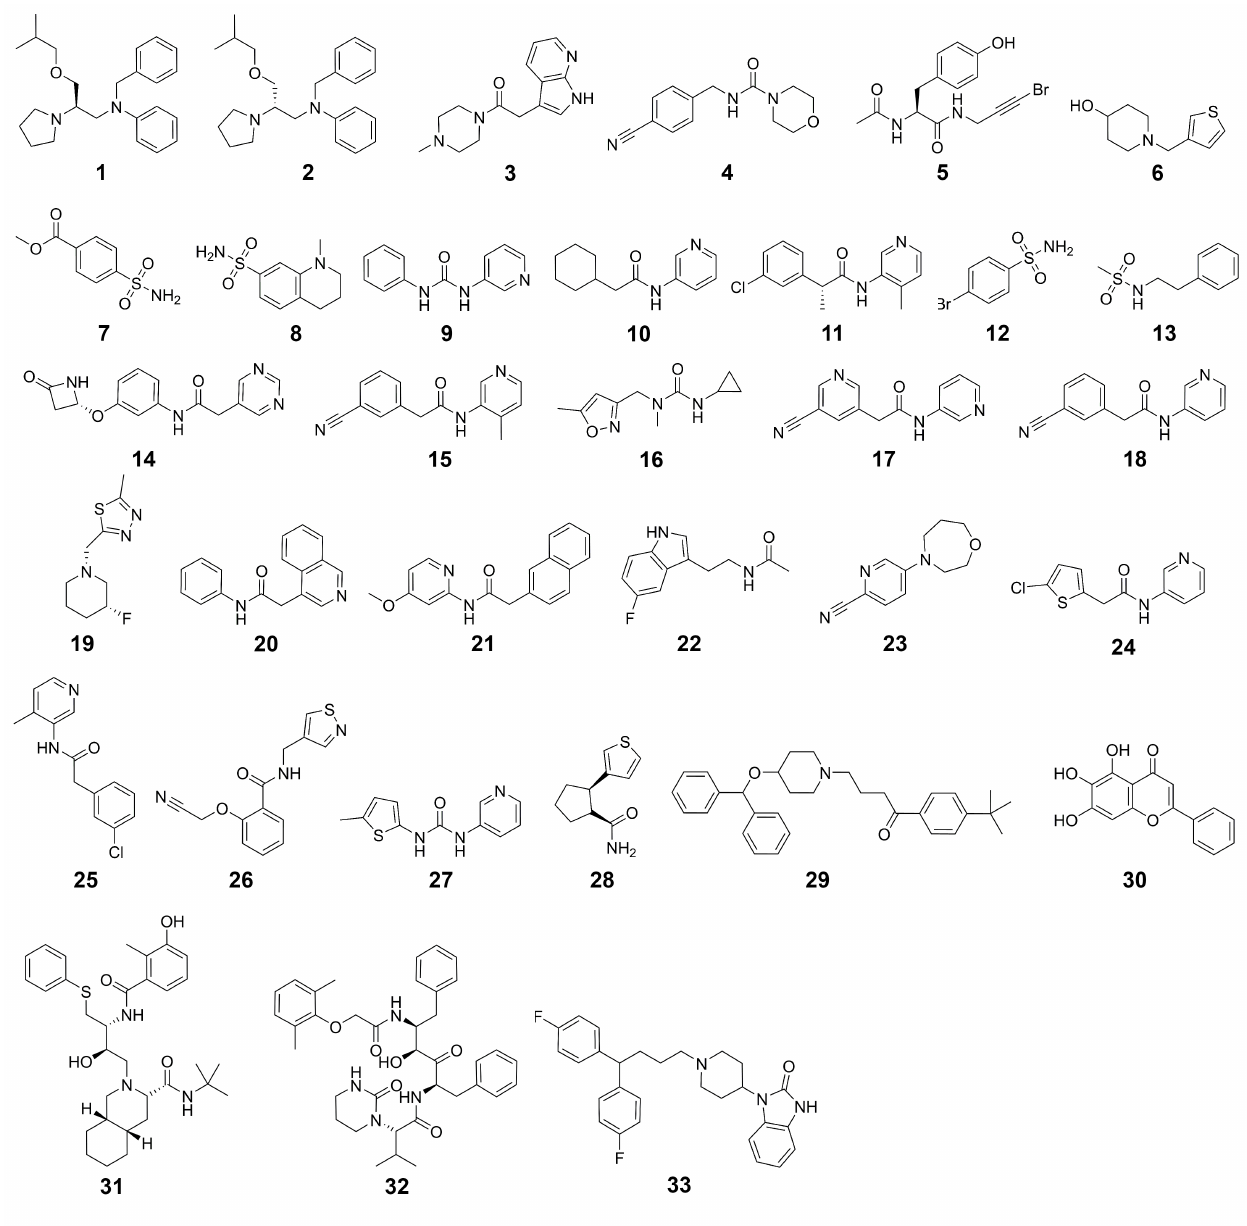
Figure 3. SARS-CoV-2 M pro inhibitors considered in this